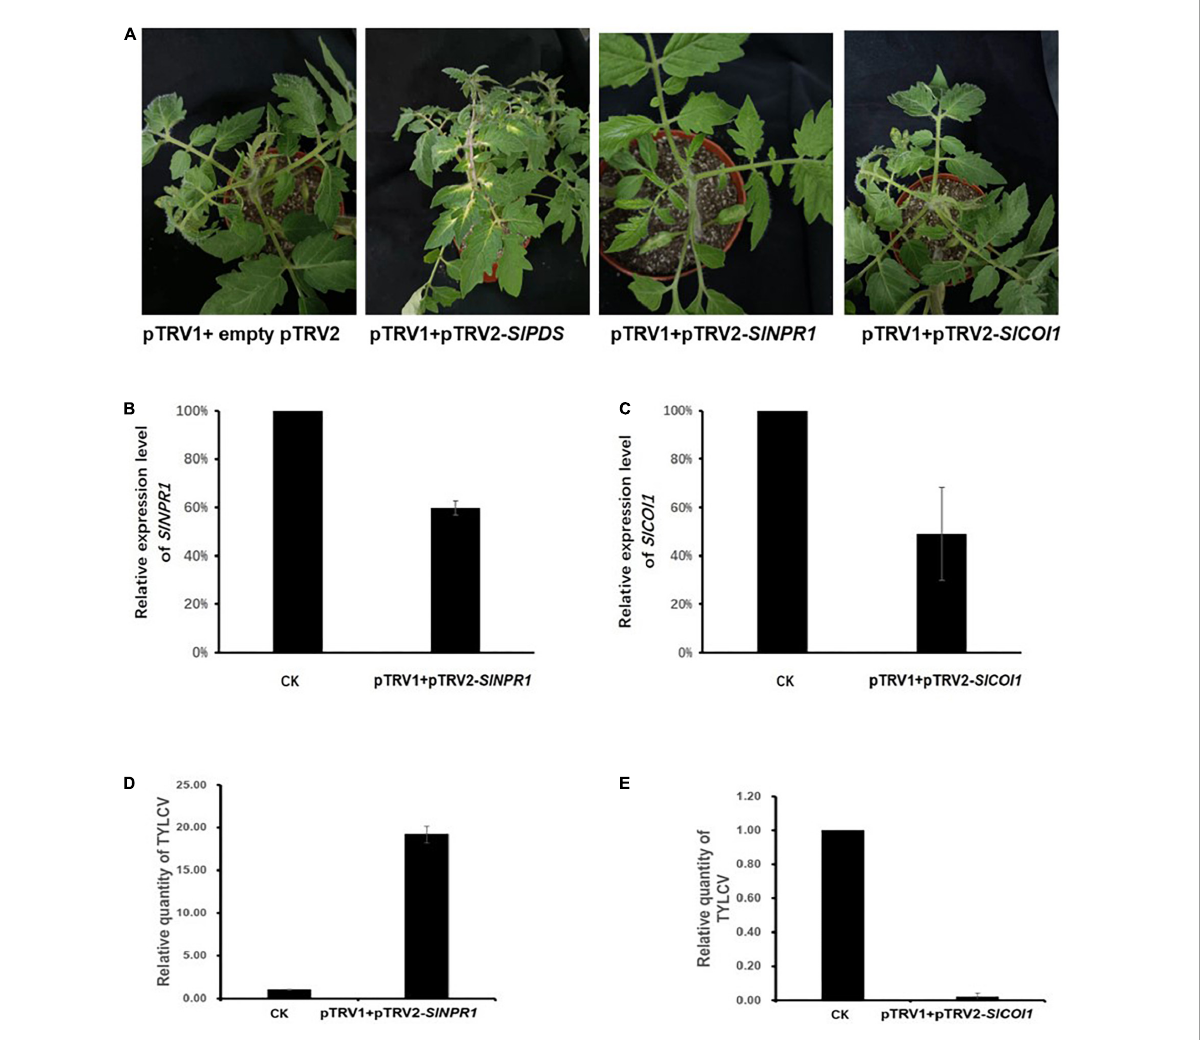
FIGURE6 Tomato yellow leaf curl virus (TYLCV) levels were affected by silencing essential genes in the salicylic acid (SA) and jasmonate acid (JA) signaling pathways. (A) The first picture (from left to right) shows the negative control plant carrying pTRV1 + empty pTRV2. The second picture shows the positive control plant carrying pTRV1 + pTRV2- SlPDS. The bleached areas in leaves were visible 2 weeks after Agro-inoculation. The third picture shows plants Agro-infiltrated with pTRV1 + pTRV2- SlNPR1 while the forth picture depicts plants Agro-infiltrated with pTRV1 + pTRV2 -SlCOI1. (B) The relatively expression levels of SlNPR1 in pTRV1 + pTRV2- SlNPR1 Agro-inoculated plants. (C) The relatively expression levels of SlCOI1 in pTRV1 + pTRV2- SlCOI1 Agro-inoculated plants. The SlNPR1 or SlCOI1 expression profile in the pTRV1 + empty pTRV2 inoculation plants (CK) was set to 1 and served as the baseline. Shown is representative data from three independent biological replicates. (D,E) The relative levels of TYLCV in pTRV1pTRV2- SlNPR1 plants and pTRV1 + pTRV2- SlCOI1 plants 7 days post inoculation of TYLCV. CK represents the baseline TYLCV levels in plants with pTRV1 + empty pTRV2 agroinfiltration. The mean and SEM are derived from pooled data corresponding to three independent biological